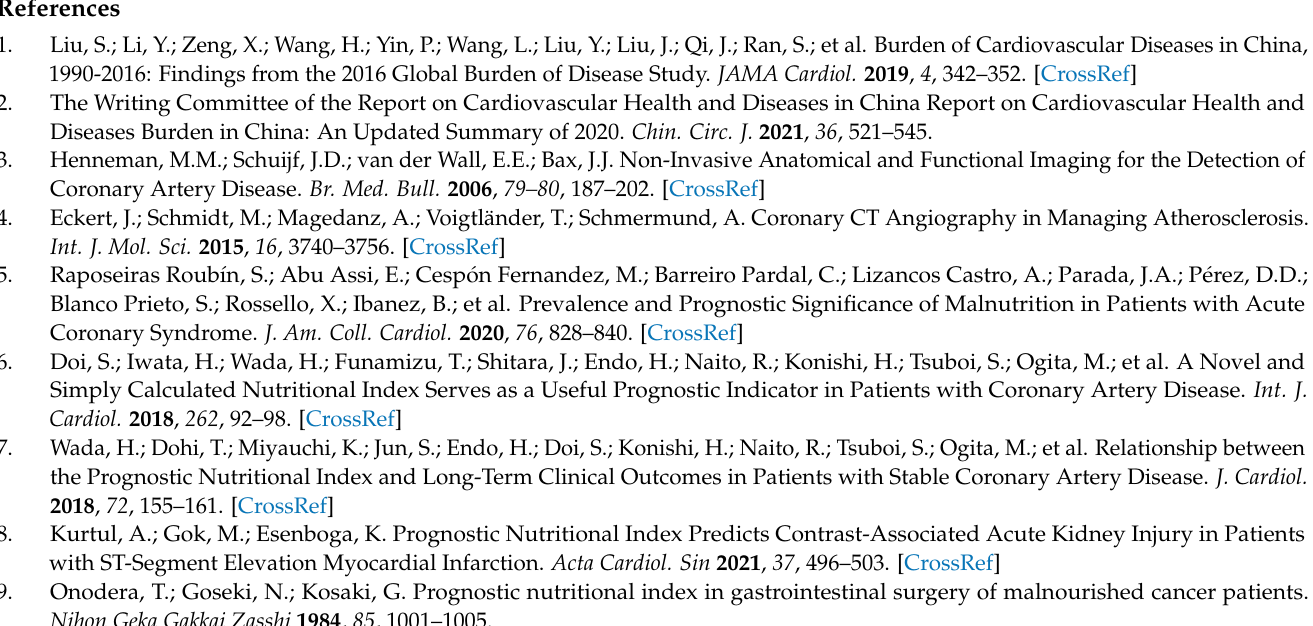
Table S1. Sensitivity analyses of the association between malnutrition and major cardiovascular event